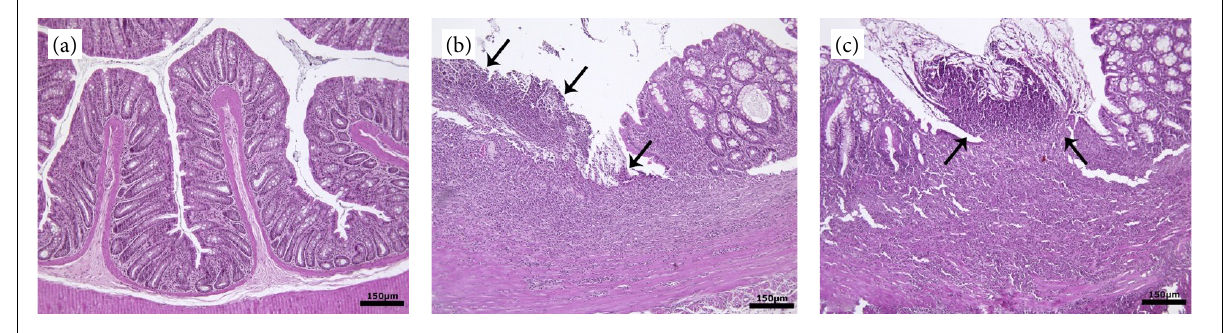
Figure 1 - Microphotographs of colons exposed to acetic acid and treated with stem cells. (a) Control group, (b) severe ulcerative inflammation ( arrows ) in a large area of the colonic mucosa in group 1. (c) Mild ulcerative inflammation ( arrows ) in group 2. Hematoxylin and eosin (H&E), bar = actual